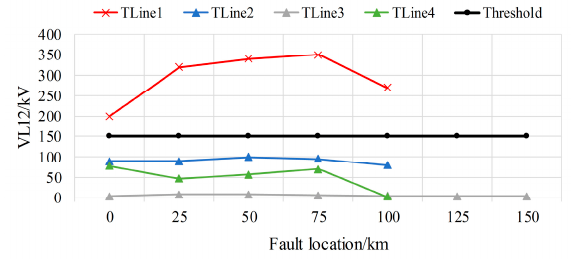
Figure 16. V L12 value when a positive pole-to-ground fault occurs.